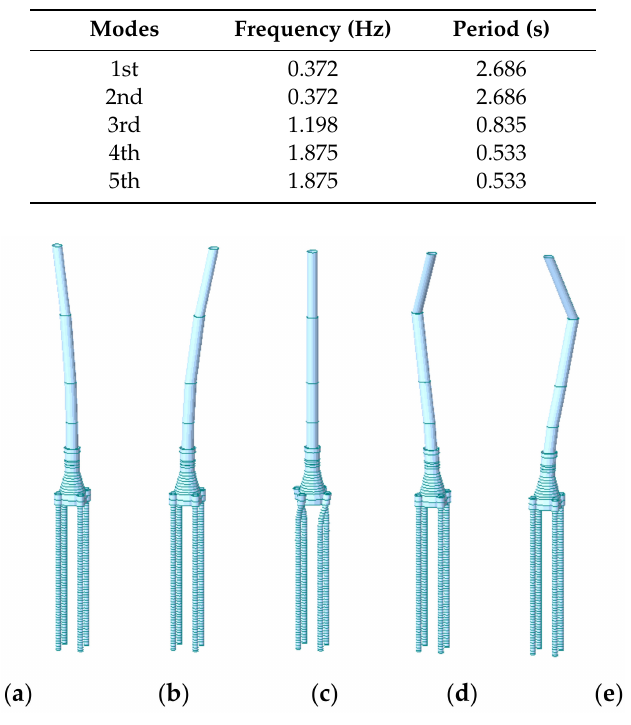
Figure 14. First five eigenmode shapes: ( a ) first mode; ( b ) second mode; ( c ) third mode; ( d ) fourth mode; and ( e ) fifth mode.